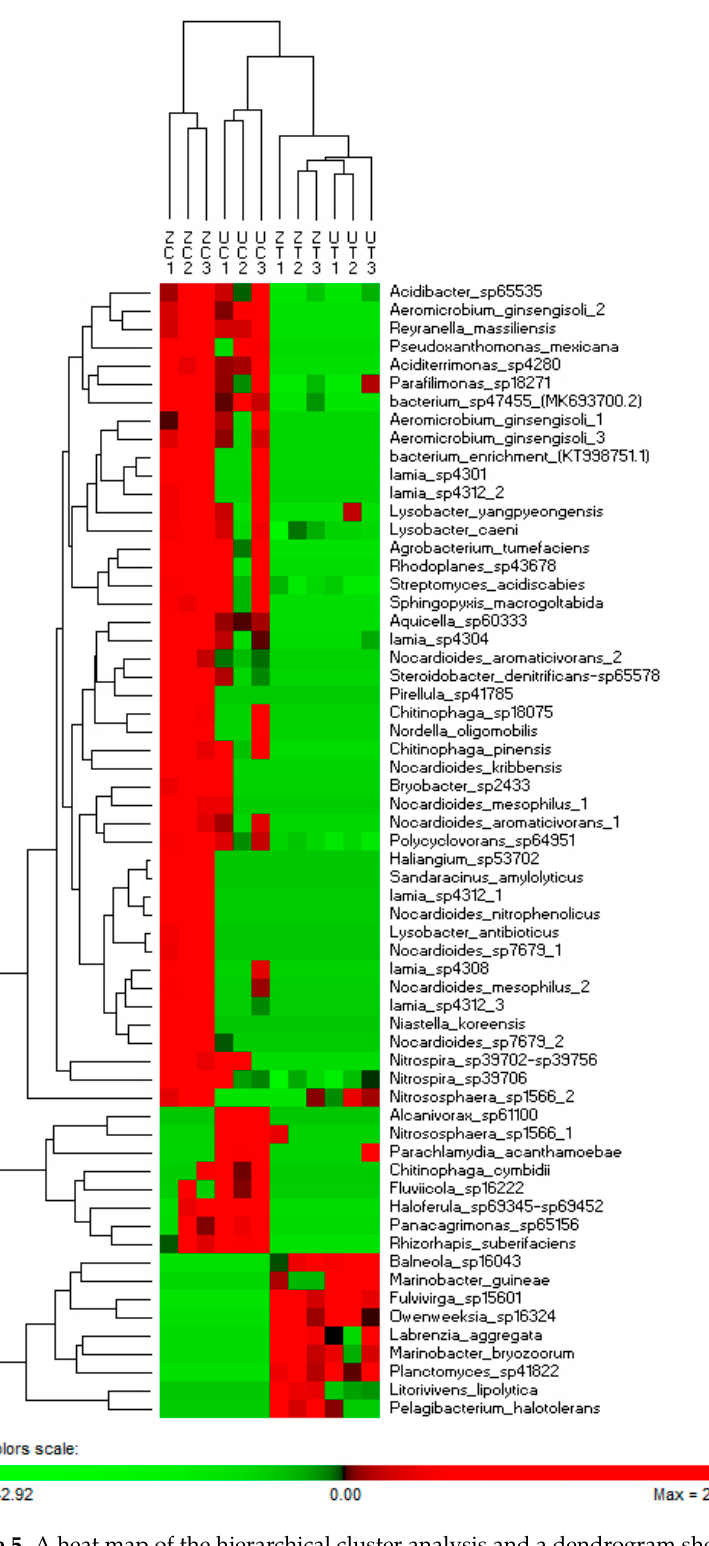
Figure 5. A heat map of the hierarchical cluster analysis and a dendrogram showing the normalized relative abundance of 62 OTUs identified from the rhizospheric bacterial communities of cultivars “Umsila” (UC) and “Zabad” (ZC) when grown under control conditions and cultivars “Umsila” (UT) and “Zabad” (ZT) when grown under salinity.